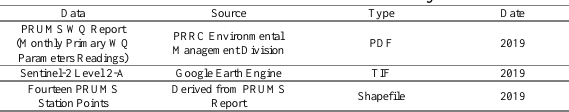
Table 1 . Summary of datasets used including source, type and